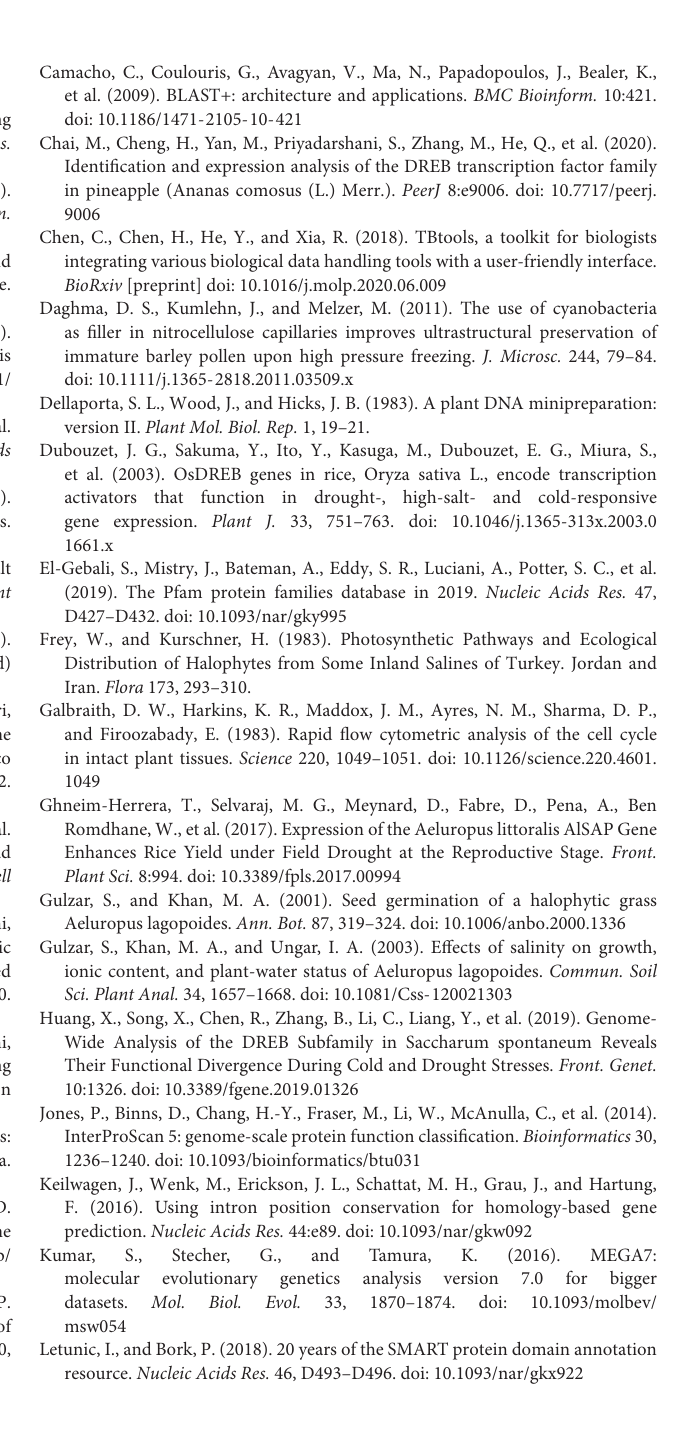
Supplementary Table 1 | Protocol for assisted chemical fixation, substitution and resin embedding for microscopy. Supplementary Table 2 | Comparison of Aeluropus genome assembly with rice, millet and stiff brome. Supplementary Table 3 | Comparison of predicted genes. Supplementary Table 4 | Sequence information of DREB-genes. Supplementary Table 5 | Sequence information for DEB